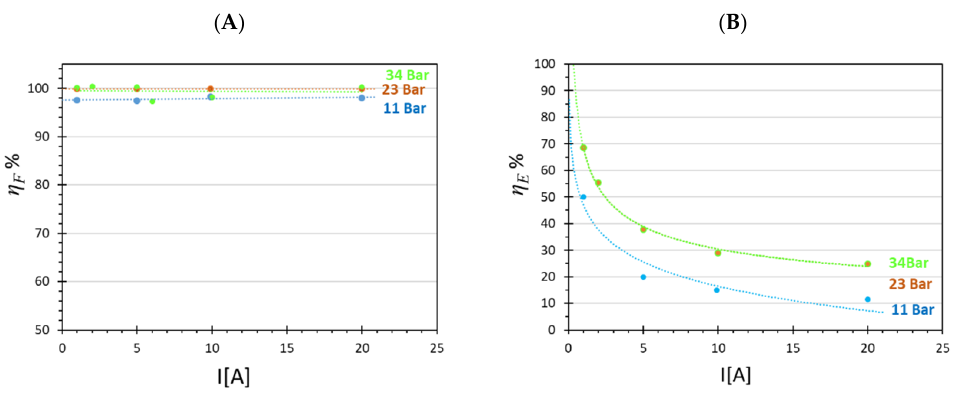
Figure 9. ( A ) Faradaic efficiency ( B ) and energety efficiency as a function of the current for the Ir-Pt-CCM at three different clamping pressures.